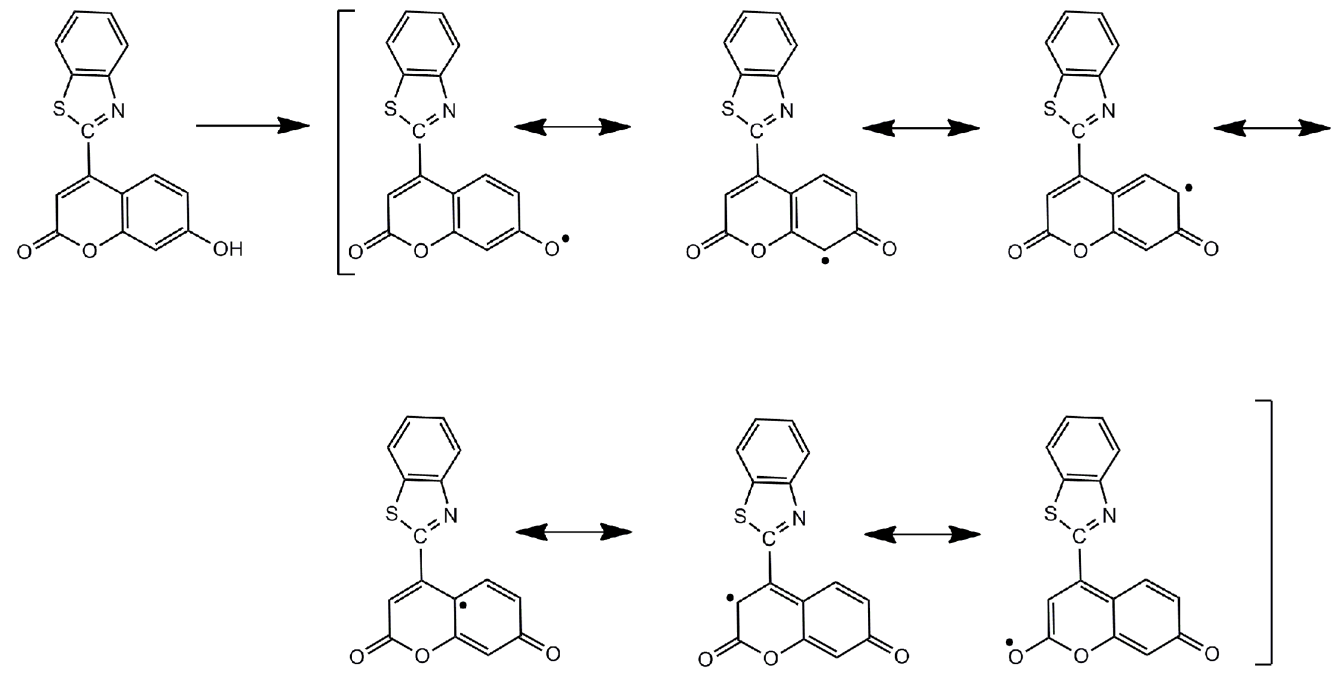
Fig 4. Suggested mechanism for compound 8 as an